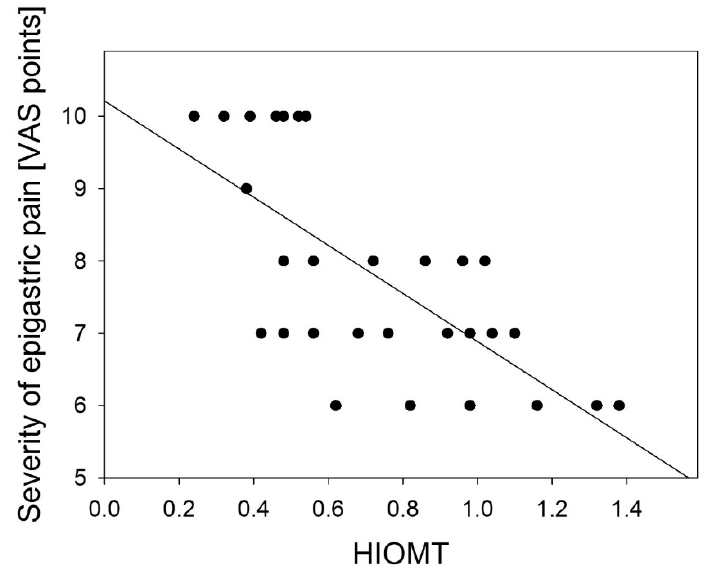
Figure 7. Correlation between hydroxyindole- O -methyltransferase (HIOMT) expression assessed as relative quantity of mRNA of HIOMT and hypoxanthine phosphoribosyltransferase (reference) by RT-PCR in body gastric mucosa and the severity of epigastric pain assessed by Visual Analog Scale (VAS) in patients with continuous epigastric pain syndrome ( n = 30). Regression line was calculated by means of the last square method, the R value was equal to − 0.698, p <